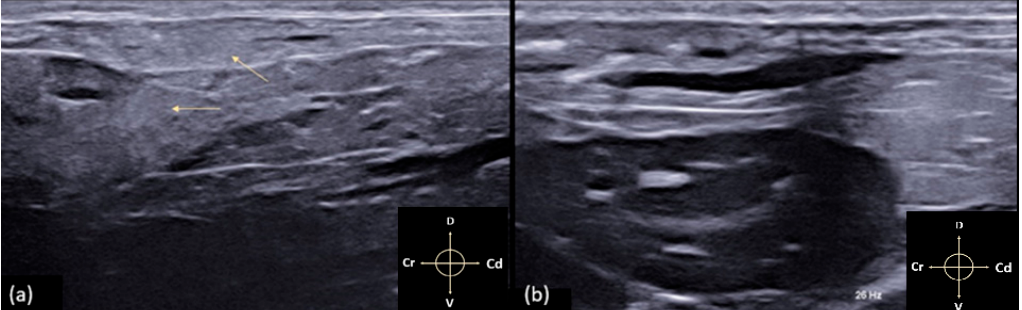
Figure 4. ( a ) The arrows indicate the increase in thickness and hypoechogenicity of the muscle planes due to the erroneous intramuscular infiltration of the test solution; ( b ) needle repositioning and correct inoculation of the solution. Arrows indicate cranial (Cr), caudal (Cd), dorsal (D) and ventral (V) directions respectively